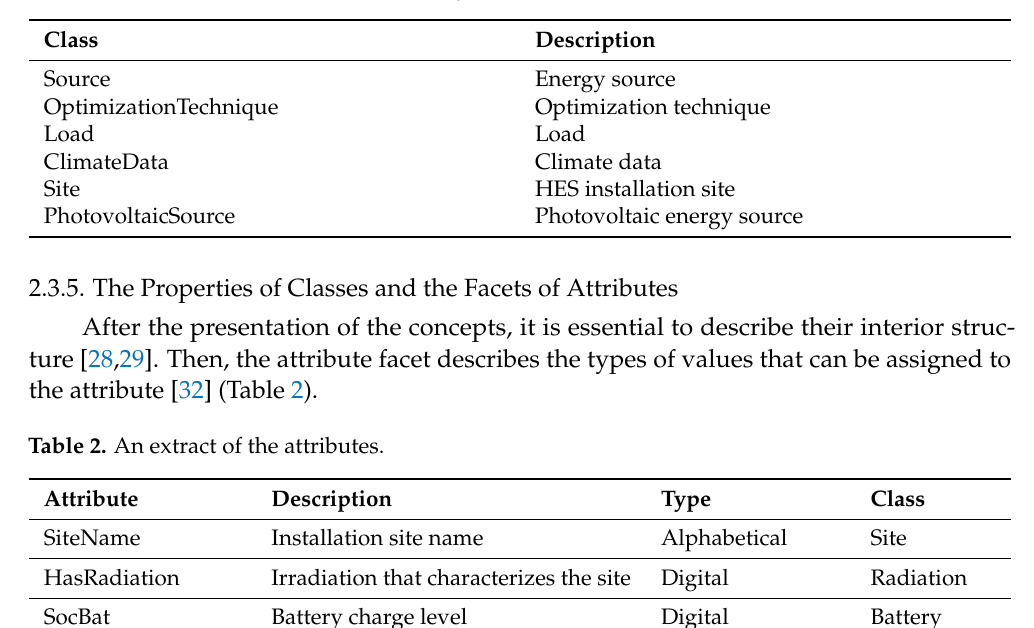
Table 1. An extract from the classes of the system.